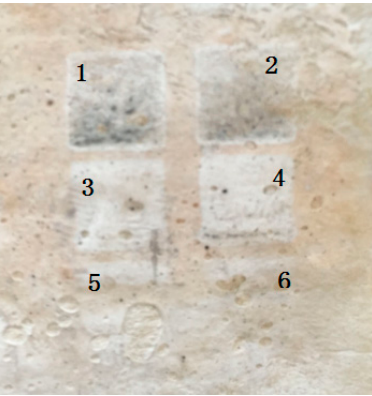
Figure 2. Effect of laser scanning speed on the Ag-deposited composite films of FP/PAN. Sample ( 1 ) 1 mm/s; ( 2 ) 2 mm/s; ( 3 ) 4 mm/s; ( 4 ) 6 mm/s; ( 5 ) 8 mm/s; ( 6 ) 10 mm/s.